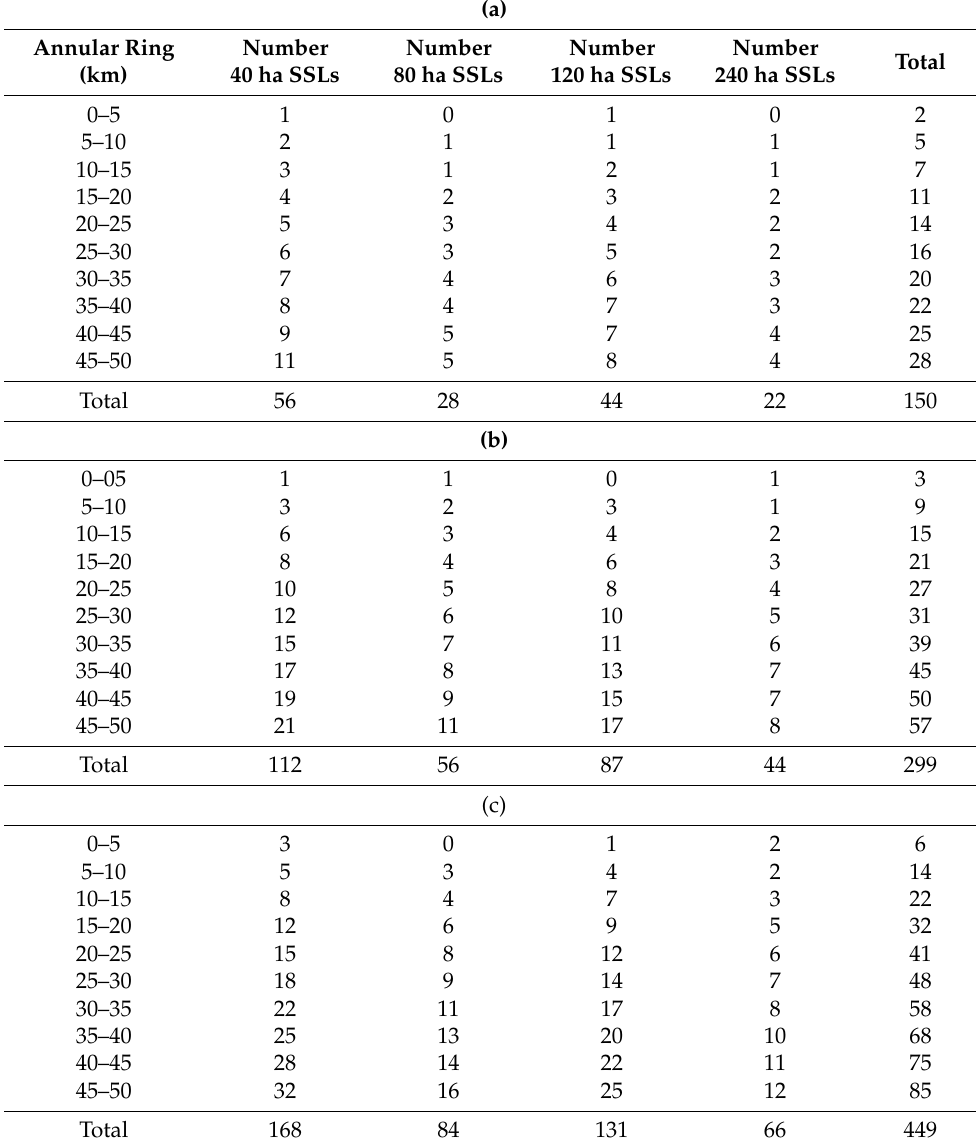
Table 2. ( a ) Distribution of SSLs supplying 0.5 bale/min biorefinery. ( b ) Distribution of